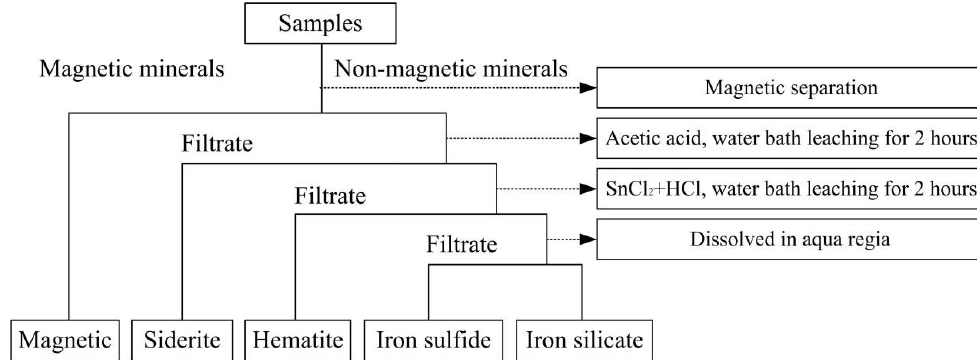
Figure 1. Iron phase analysis process. Table 2. Analysis result of iron phase (mass %).